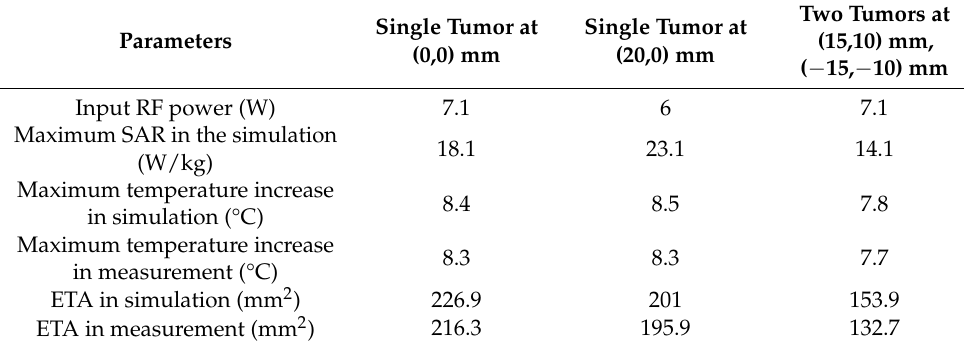
Figure 13. The transient temperature distribution at the tumor center: ( a ) single tumor at (0,0) mm, ( b ) single tumor at (20,0) mm, and ( c ) two tumors at (15,10) mm and (−15,−10) mm. Table 5. Comparison of the simulation and measurement results.